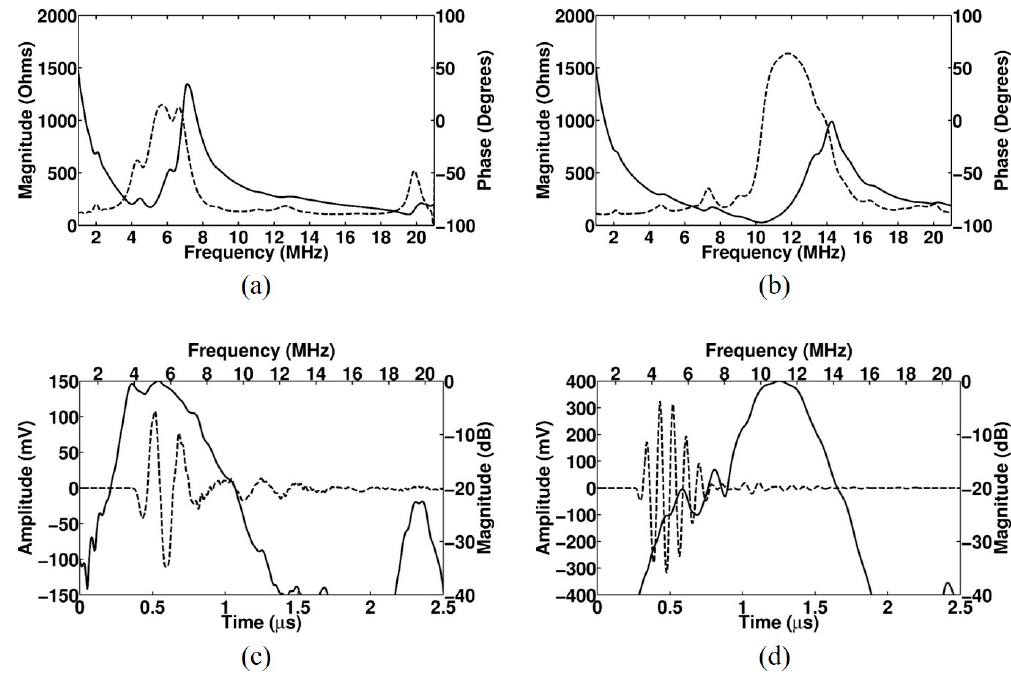
Figure 4. FEA simulated electrical impedance (solid line: magnitude; dashed line: phase) and pulse–echo response (solid line: frequency-domain spectrum; dashed line: time-domain waveform) of the proposed linear array transducer with matching layers: ( a ) Electrical impedance of the conventional element, ( b ) electrical impedance of the PIT element, ( c ) pulse–echo response of the conventional element, and ( d ) pulse–echo response of the PIT element.